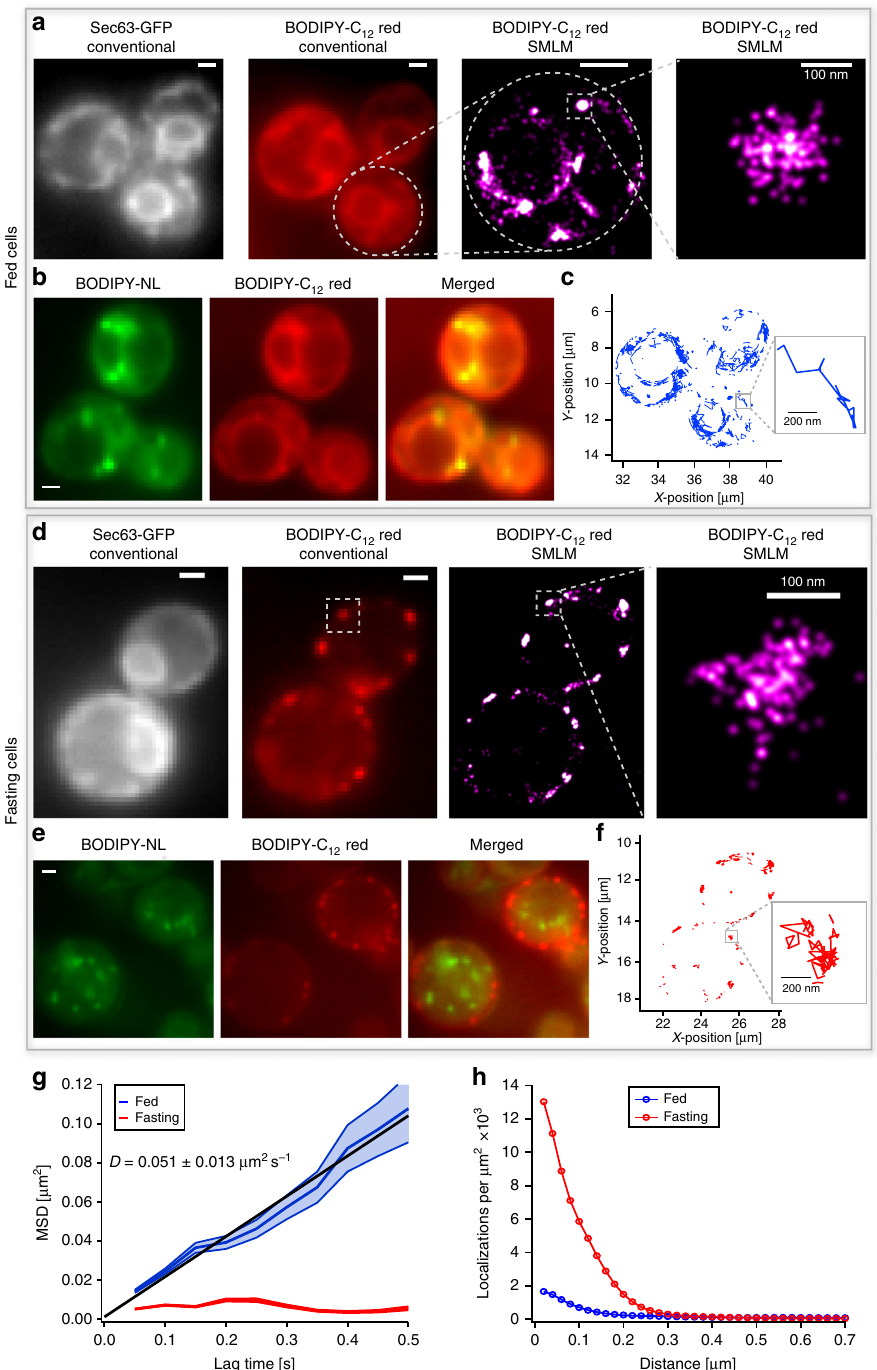
Fig. 4 Differential nanoscale localization and dynamics of fatty acid analogs depend on metabolic state of cells. a Conventional fl uorescence images of BODIPY-C 12 red exhibit co-localization with the ER protein Sec63-2 × GFP under fed condition. The SMLM image of BODIPY-C 12 red shows the ER membrane in high resolution and distinct spots on the ER below the optical diffraction limit. b The co-localization of BODIPY-C 12 red with BODIPY-NL shows that denser spots of BODIPY-C 12 co-localize with LDs. c The single-molecule tracking of BODIPY-C 12 red reveals predominantly free diffusion along the ER membrane. d Under fasted conditions, added BODIPY-C 12 red forms distinct puncta along the cell periphery that do not co-localize with Sec63-2 × GFP at the nuclear portion of the ER. The super-resolution images resolve puncta below the diffraction limit. e The distinct BODIPY-C 12 red puncta do not co-localize with LDs (BODIPY-NL) in fasting cells. f The single-molecule tracking of BODIPY-C 12 red exhibits mostly con fi ned immobilization in fasting cells. g The MSD vs. time of BODIPY-C 12 red molecules shows free diffusion ( D = 0.051 ± 0.013 μ m 2 s − 1 ) under fed conditions (blue) and con fi ned immobilization under fasted conditions (red) (Fed: 321 traces; Fasted: 151 traces; error: standard deviation from 6 movies each with > 3 cells). h The radial distribution function shows high-density clusters of BODIPY-C 12 red localizations upon fasting (red) and a much smaller fraction of clustered localizations in fed cells (blue) (Fed: 4219 localizations, 2 cells; Fasted: 4933 localizations, 2 cells). Scale bar: 1 µ m unless speci fi